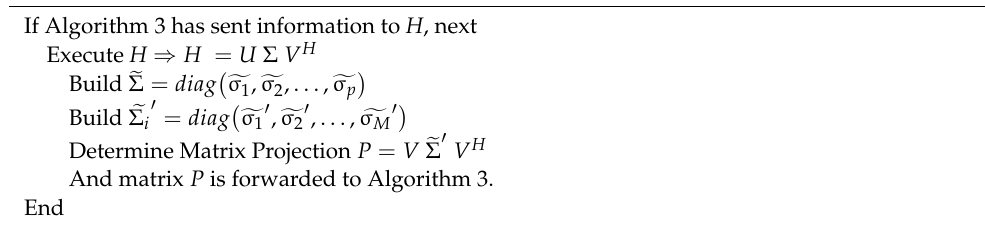
Algorithm 4 . Projection Algorithm 4 on 2nd